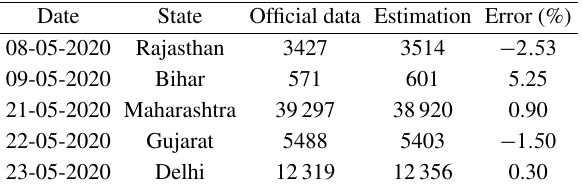
Table 8 Comparison of total reported and estimated cured